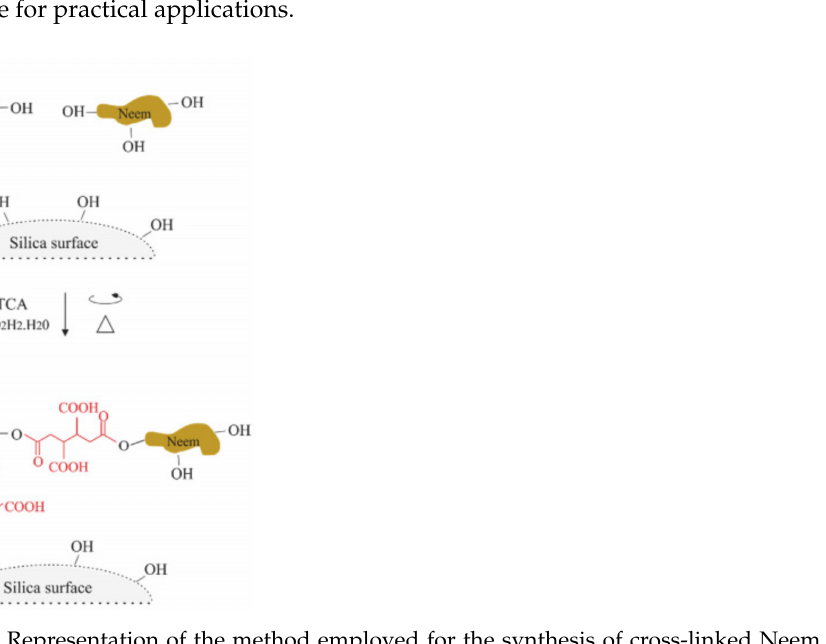
Figure 15. Representation of the method employed for the synthesis of cross-linked Neem Bark Extracts in silica surface with BTCA. Retrieved from